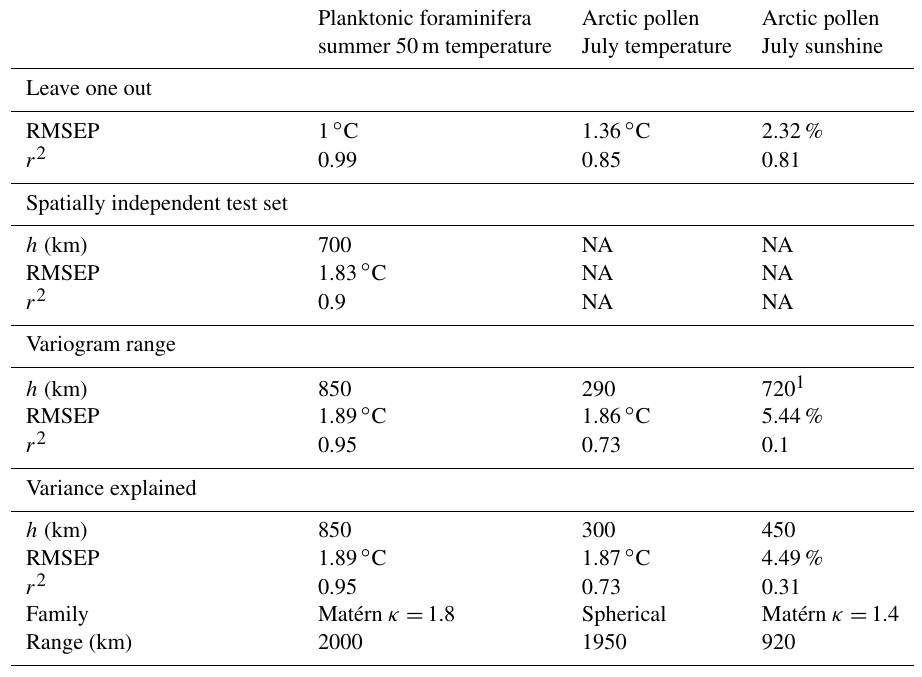
Table 1. Comparison of transfer-function performances of published transfer functions. Planktonic foraminifera Arctic pollen Arctic pollen